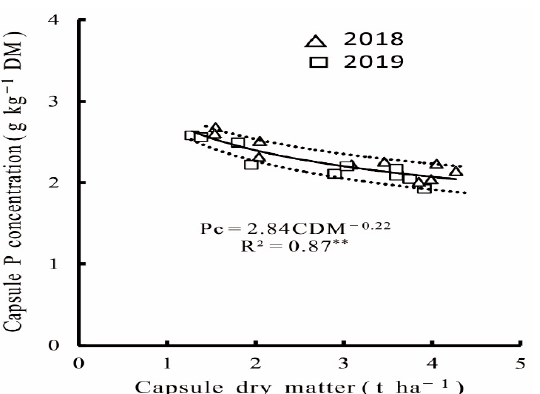
Figure 5. Critical phosphorus (Pc) data points for the capsule Pc curve definition using pooled data from two years. The solid line represents the critical P dilution curve (Pc = 2.84 CDM − 0.22 , R 2 = 0.82 **), which describes the relationship between the critical P concentration and the capsule dry matter of flax in northwest China. The dotted lines represent the confidence intervals ( p = 0.95). ** Significance at p < 0.01 probability level.